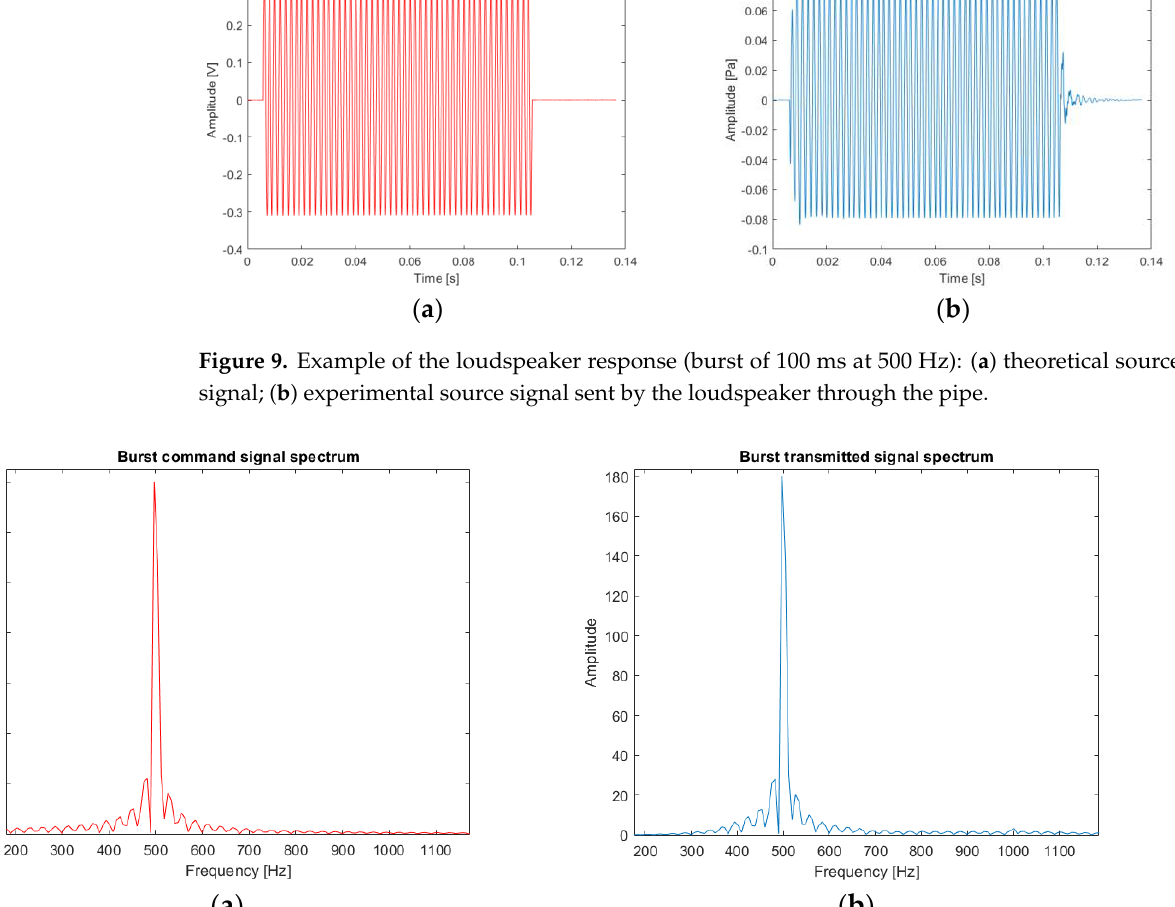
Figure 10. Fourier transform of the burst of 100 ms at 500 Hz: ( a ) theoretical burst spectrum;